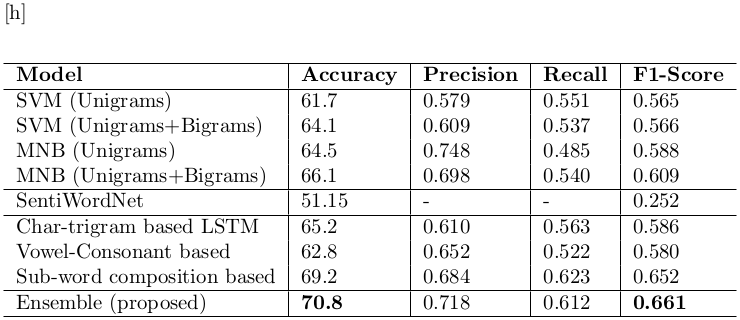
Table from the paper: An Ensemble Model for Sentiment Analysis of Hindi-English Code-Mixed Data
Table text:
[h]
Model
Accuracy
Precision
Recall
F1-Score
SVM(Unigrams)
61.7
0.579
0.551
0.565
SVM(Unigrams+Bigrams)
64.1
0.609
0.537
0.566
MNB(Unigrams)
64.5
0.748
0.485
0.588
MNB(Unigrams+Bigrams)
66.1
0.698
0.540
0.609
SentiWordNet
51.15
-
-
0.252
Char-trigrambasedLSTM
65.2
0.610
0.563
0.586
Vowel-Consonantbased
62.8
0.652
0.522
0.580
Sub-wordcompositionbased
69.2
0.684
0.623
0.652
Ensemble(proposed)
70.8
0.718
0.612
0.661